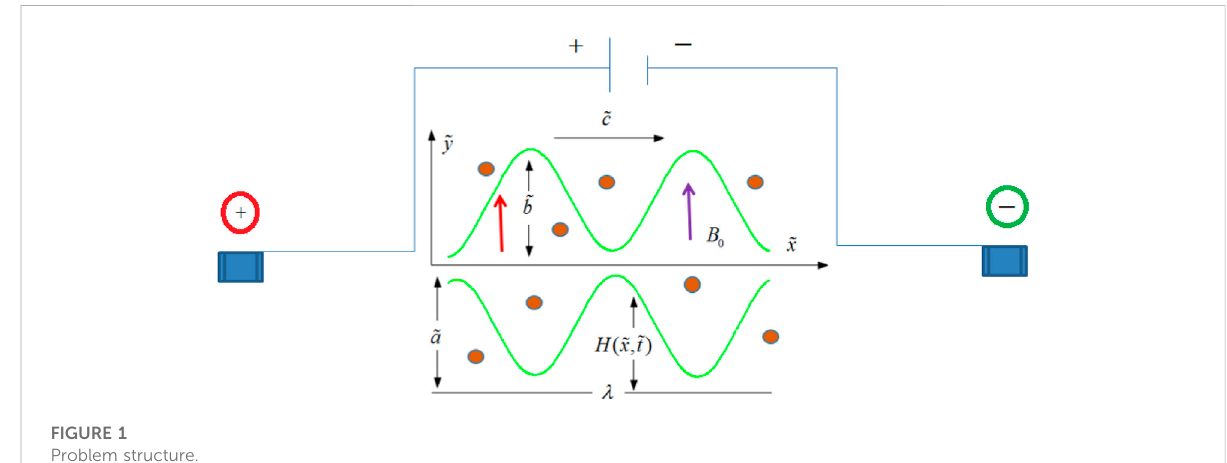
FIGURE 1 Problem